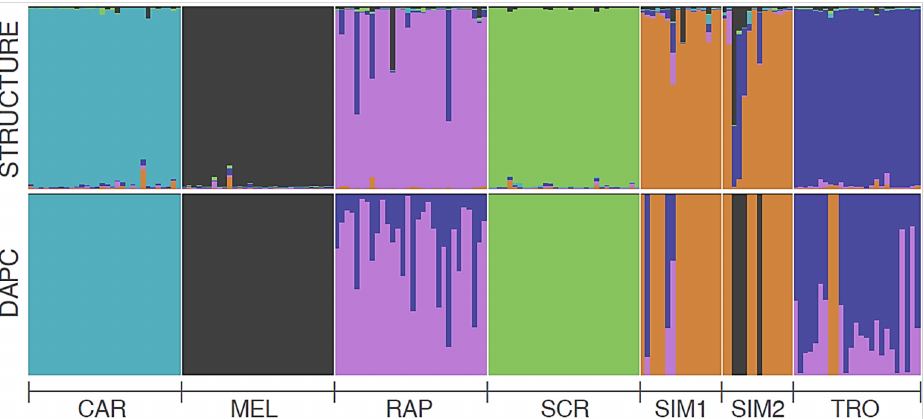
Figure 4. Barplots of individual, STR-based admixture as obtained through the Bayesian clustering analysis in S TRUCTURE (above) and the D APC assignment procedure (below) for the optimal number of inferred clusters (K = 6). Population abbreviations refer to Table 1.